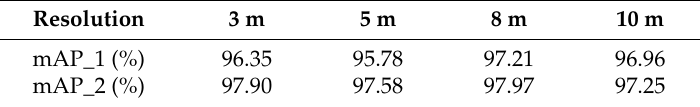
Table 6. The ship detection results validated with Automatic Identification System (AIS) for the Cosmo ‐ SkyMed image.